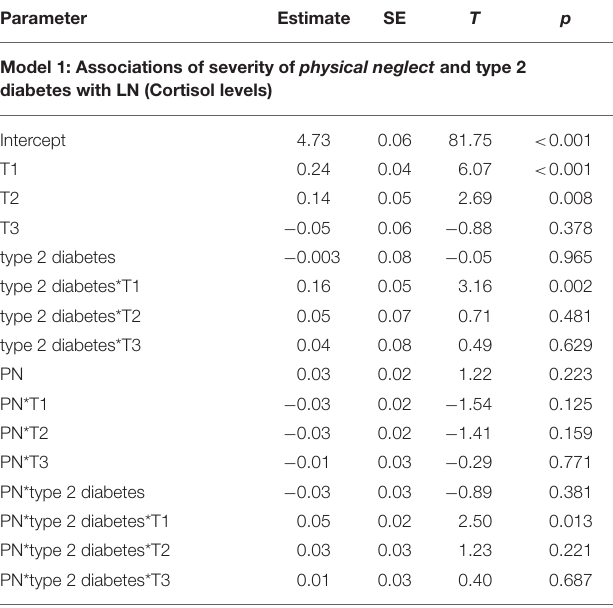
Model 2: Associations of severity of emotional neglect and type 2 diabetes with LN (Cortisol levels)